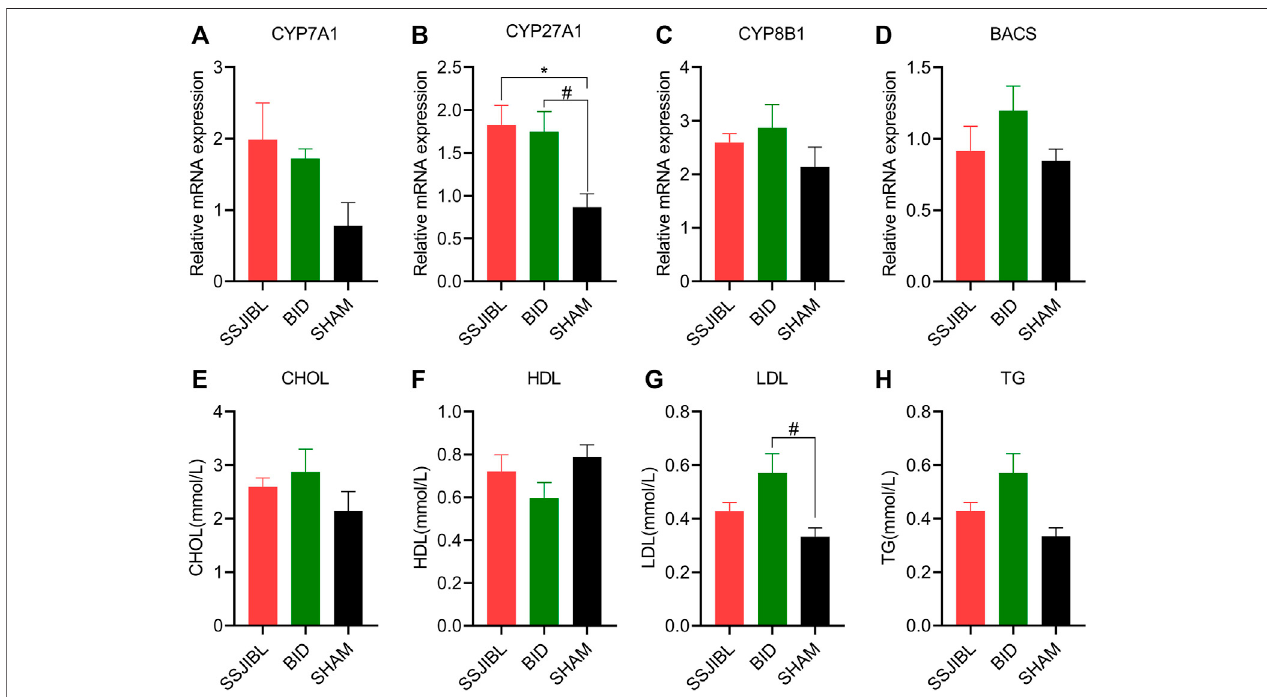
FIGURE4|(A – D) RelativemRNAexpressionofenzymesCYP7A1,CYP27A1,CYP8B1,andBACSintheliver( n =6forSSJIBL, n =6forSham,and n =6forBID). GAPDH was used as an internal control. (E – H) Total TG, CHOL, HDL, and LDL levels in blood. TG, triglyceride; CHOL, cholesterol; HDL, high-density lipoprotein; LDL, low-density lipoprotein. # p < 0.05 for BID versus SHAM group. * p < 0.05 for SSJIBL versus SHAM